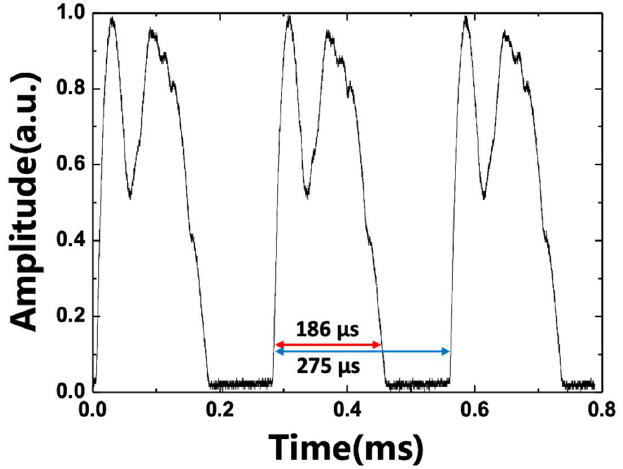
m after optimization of alignment.